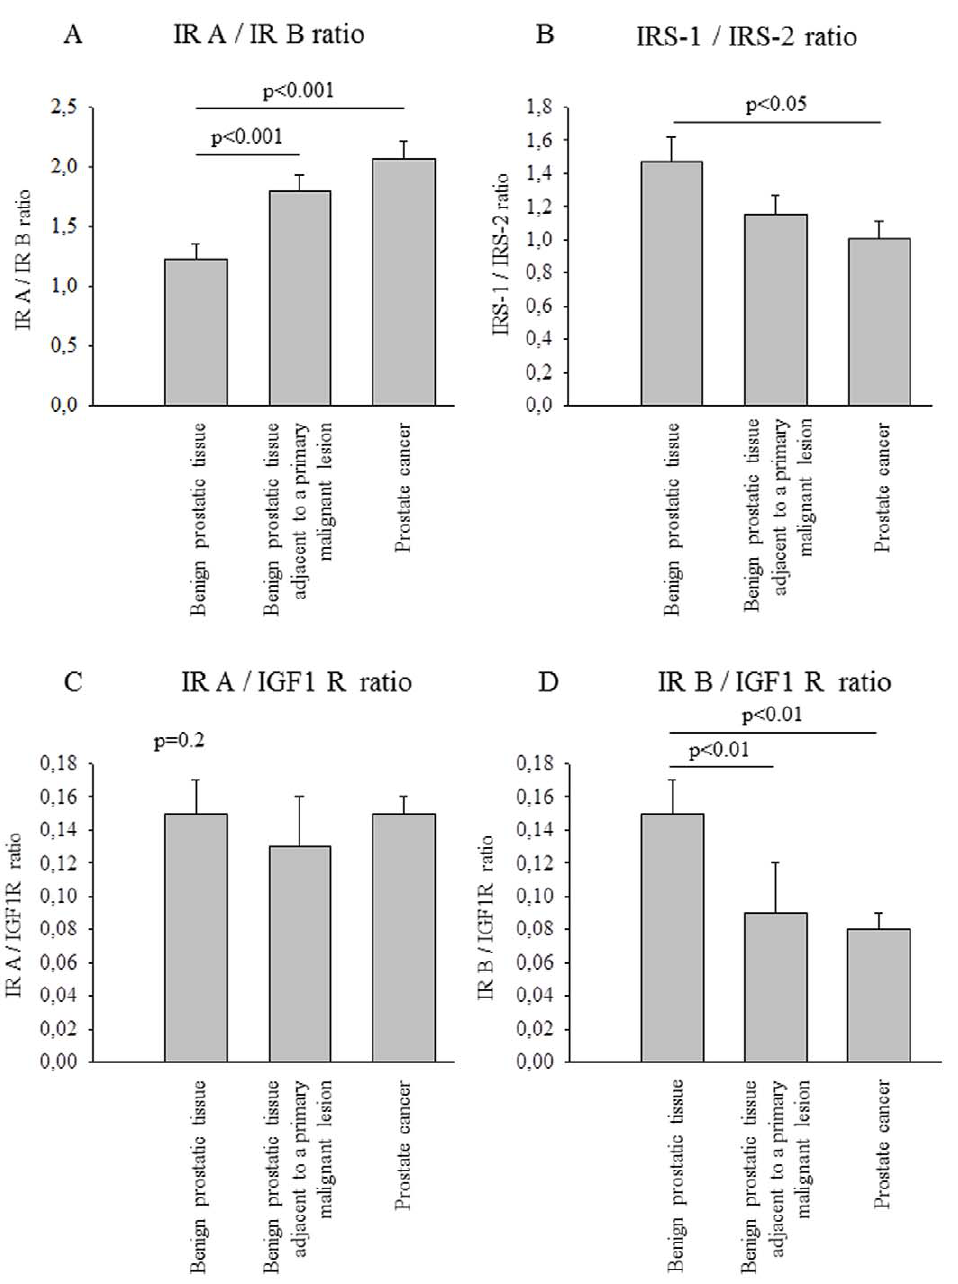
Figure 1. Proportion of the analyzed RNA expressions. Bars represent means + SEM., N=88. Data were log e -transformed prior to statistical analysis. When comparison between groups by ANOVA resulted in statistically significant differences, Tukey Kramer post-hoc test was performed. Statistically significant results of this test are given in the figures. (A) Insulin receptor isoform A/Insulin receptor isoform B ratio. ANOVA p=0.0002. (B) IRS-1/IRS-2 ratio. ANOVA p=0.0426. (C) Insulin receptor isoform A/IGF 1 receptor ratio. ANOVA p=0.2. (D) Insulin receptor isoform B/IGF 1 receptor ratio. ANOVA p=0.0016. ANOVA – analysis of variance; IGF – insulin-like growth factor; IR – insulin receptor; IRS – insulin receptor substrate; RNA – ribonucleic acid; SEM – standard error of the